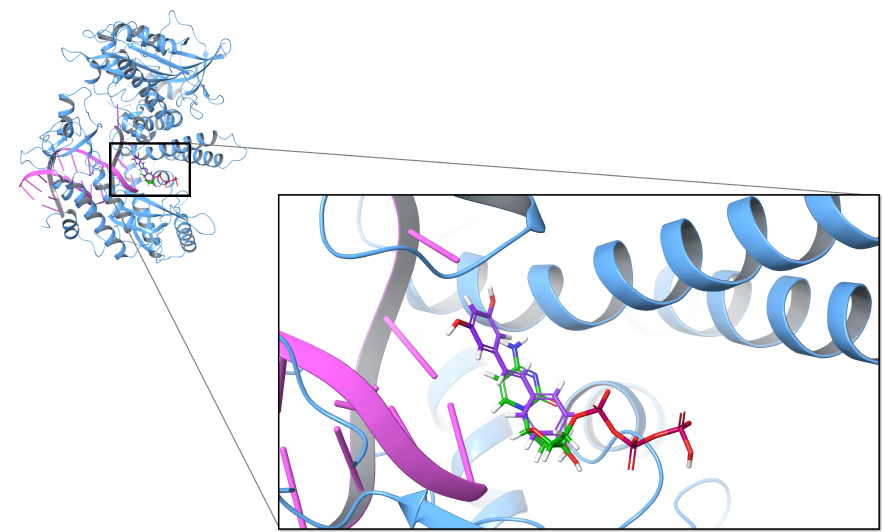
Figure 1. Superposition of two docking poses of trans -resveratrol (purple) and dCTP (green) on DNA polymerase α (PDB ID: